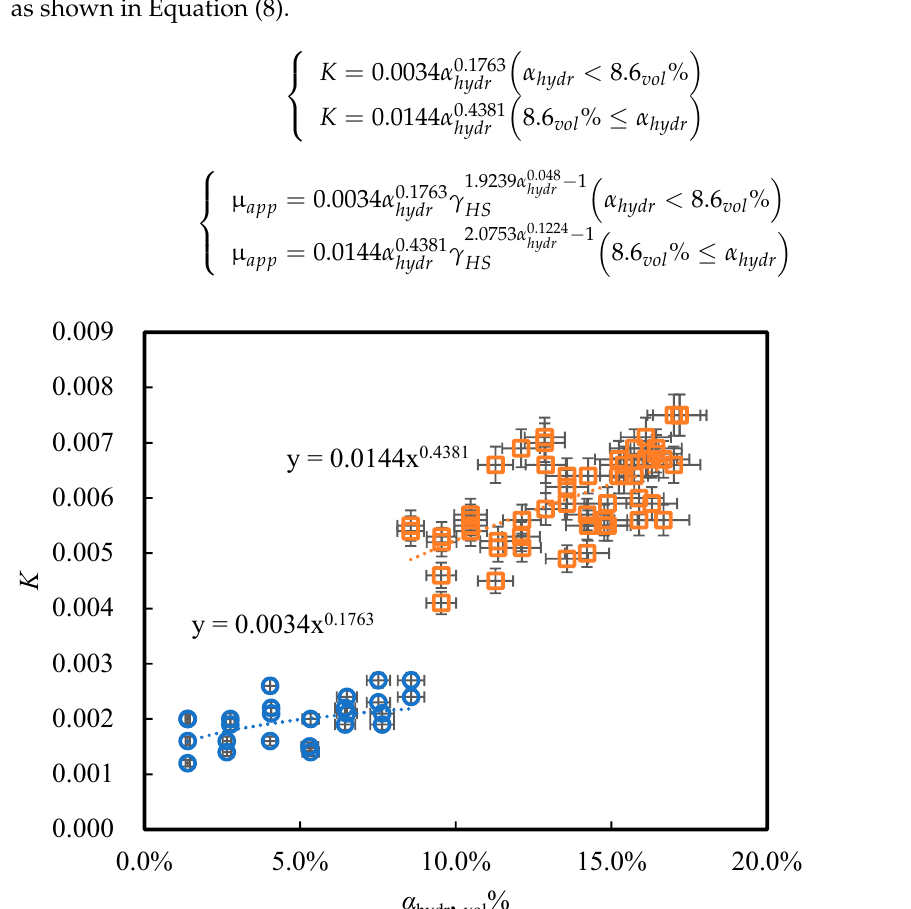
Figure 8. Evolution of the consistency factor K of a function of volumetric hydrate fraction for CO 2 hydrate slurry.